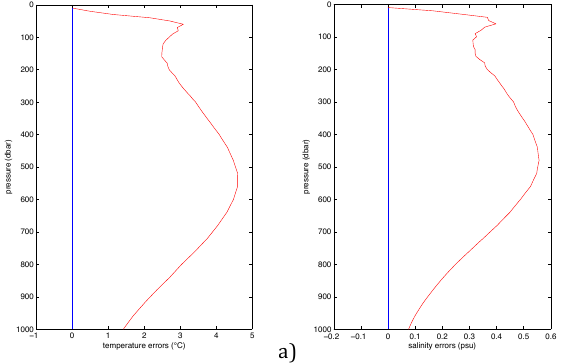
Fig. 5. Hindcast temperature (a) and salinity (b) mean bias errors (blue) and standard deviation errors (red) when using only the first mode in the mEOF-r trivariate reconstructions: (a) mEOF-r( T - S - SH) SST-SSH , (b) mEOF-r( T - S -SH) SSS-SSH